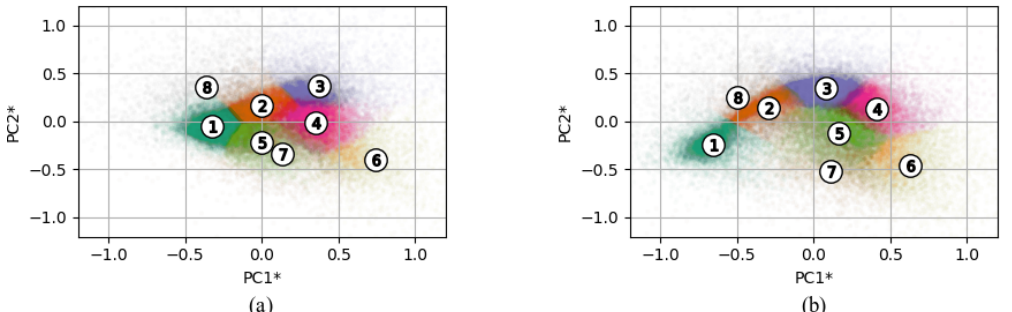
Figure 7. Projection of the samples onto the PC1, PC2 space for the offshore (a) and onshore (b) locations. The colour indicates the cluster to which a sample belongs, and the markers represent the cluster centroids. The plots share the same coordinate system as the x axis ( y axis), aligned with the average of the PC1 (PC2) unit vectors from the two reference locations. The averaged PCs are denoted by an asterisk and their profiles shown in Figs. 2 and 11 (b, f) .